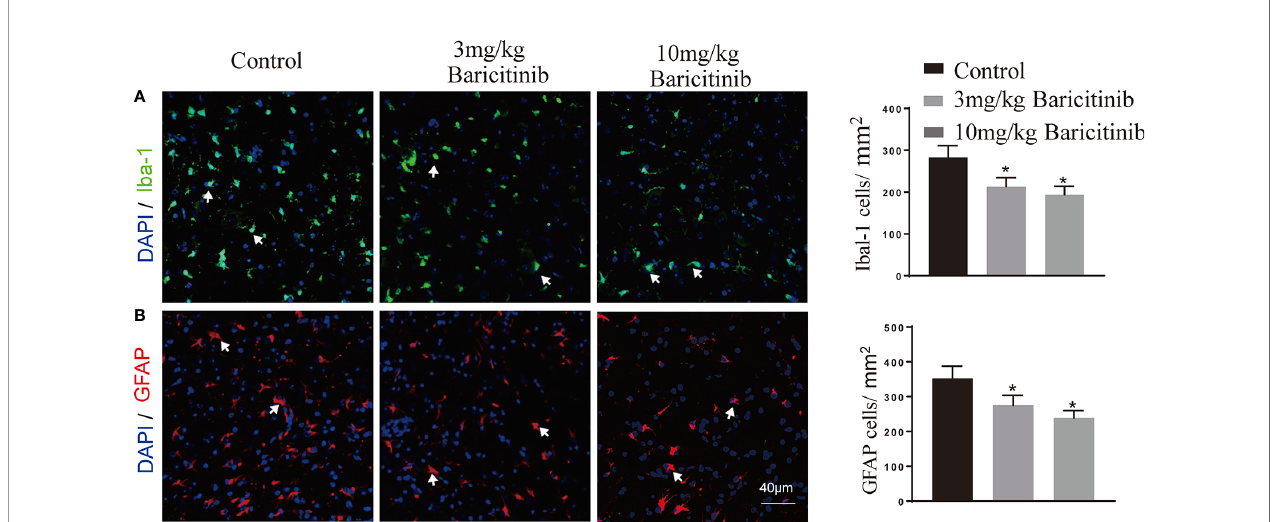
FIGURE 4 | Representative images and distribution of microglia (Iba-1) and astrocytes (GFAP) in spinal cord of EAE mice. (A) Signi fi cantly lower Iba-1 positive cells (microglia) count was recorded in the baricitinib-treated groups when compared with the control group. (B) Representative immunostained images showing the distribution of astrocytes. GFAP positive cells (astrocytes) decreased signi fi cantly in the baricitinib-treated groups when compared with the control group. 5 sections per animal. Quantitative data are the mean ± SEM. * p < 0.05; n = 6 per group.